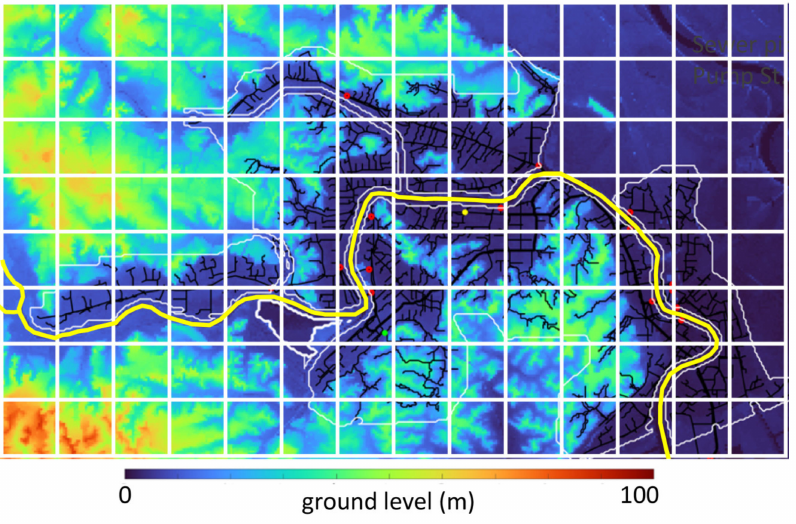
Figure 4. An example of evenly segmented sections ( N x = 14 and N y =